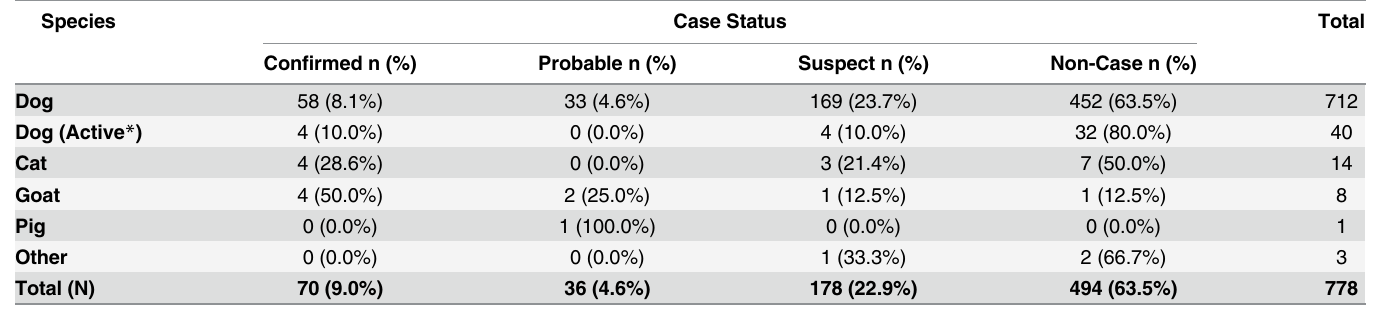
Table 1. Rabies case status by animal species, Haiti January 2013 – December 2014.